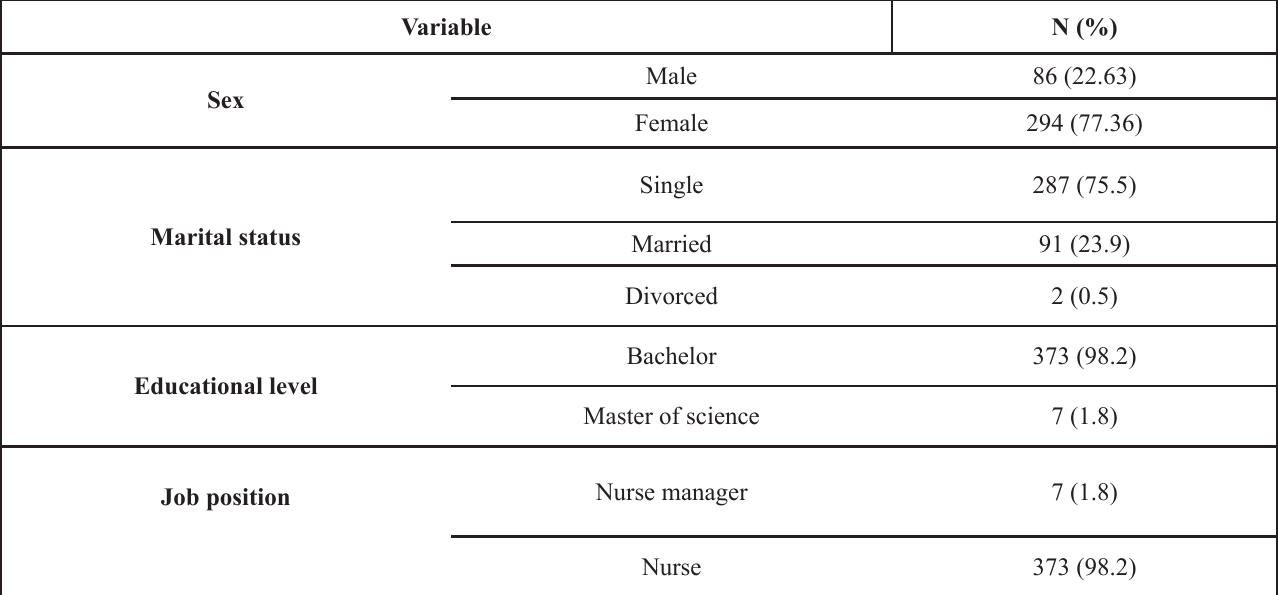
Table 1. Demographic characteristics of the studied